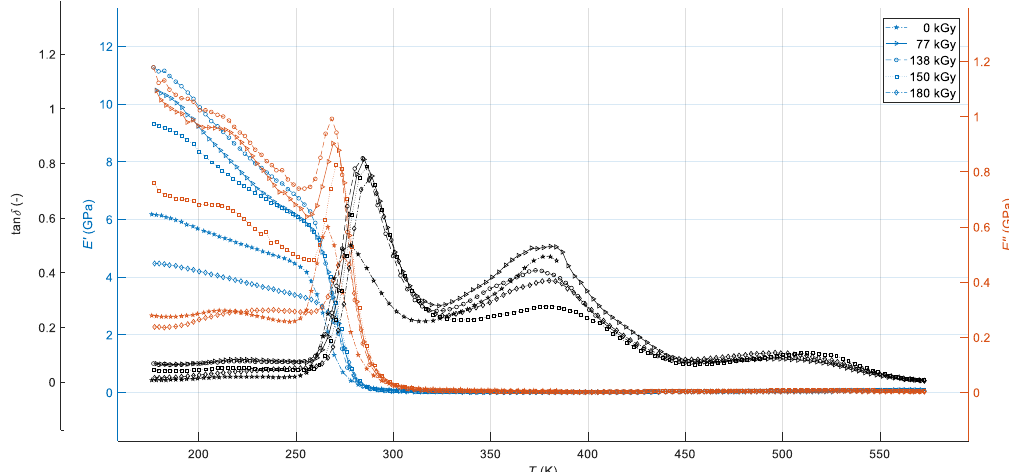
Figure 1. Dynamic mechanical response of PMX3 resin-rubber blend for various EB radiation doses as a function of temperature.